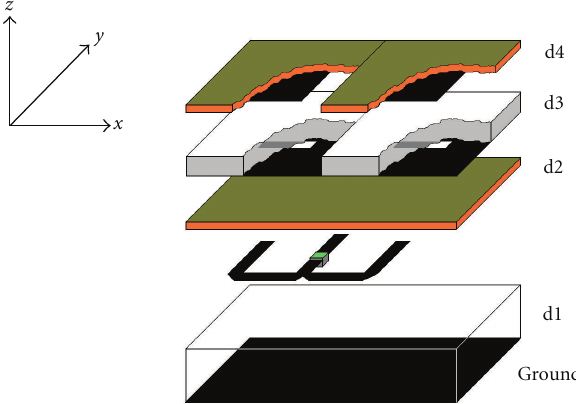
Figure 5: Expanded view of a gathered reconfigurable element based on patches, aperture-coupled to delay